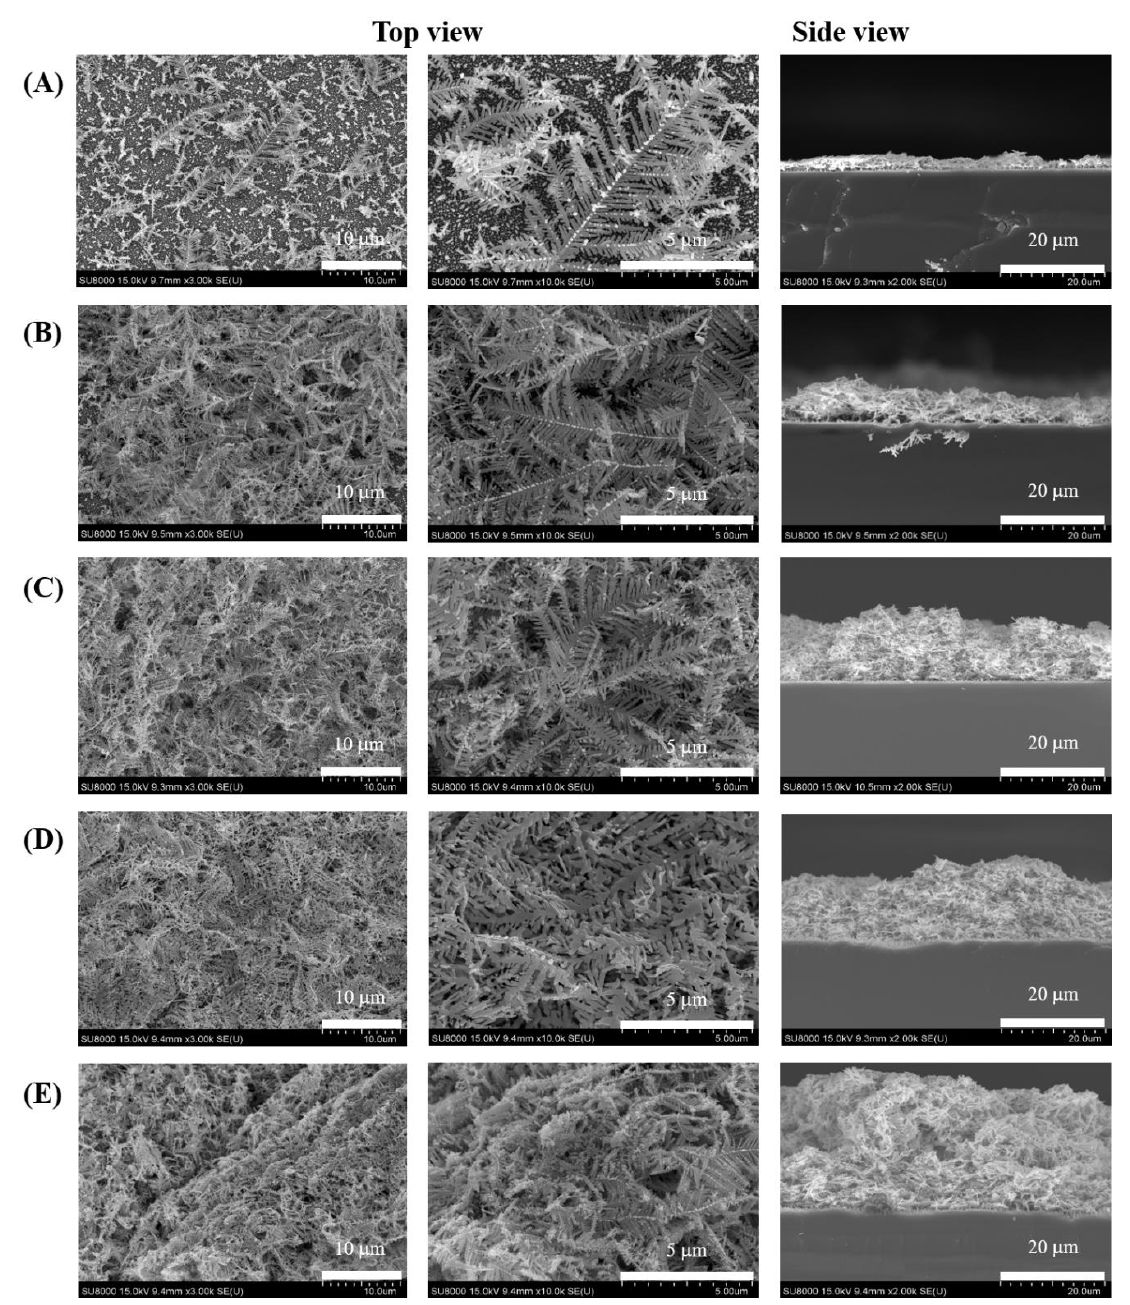
Figure 8. Representative SEM images of Ag nanostructures prepared with various reaction times: ( A ) 0.5, ( B ) 1.0, ( C ) 3.0, ( D ) 5.0, and ( E ) 10.0 min. Scale bar: 10 µm, 5 µm (top view) and 20 µm (side view).